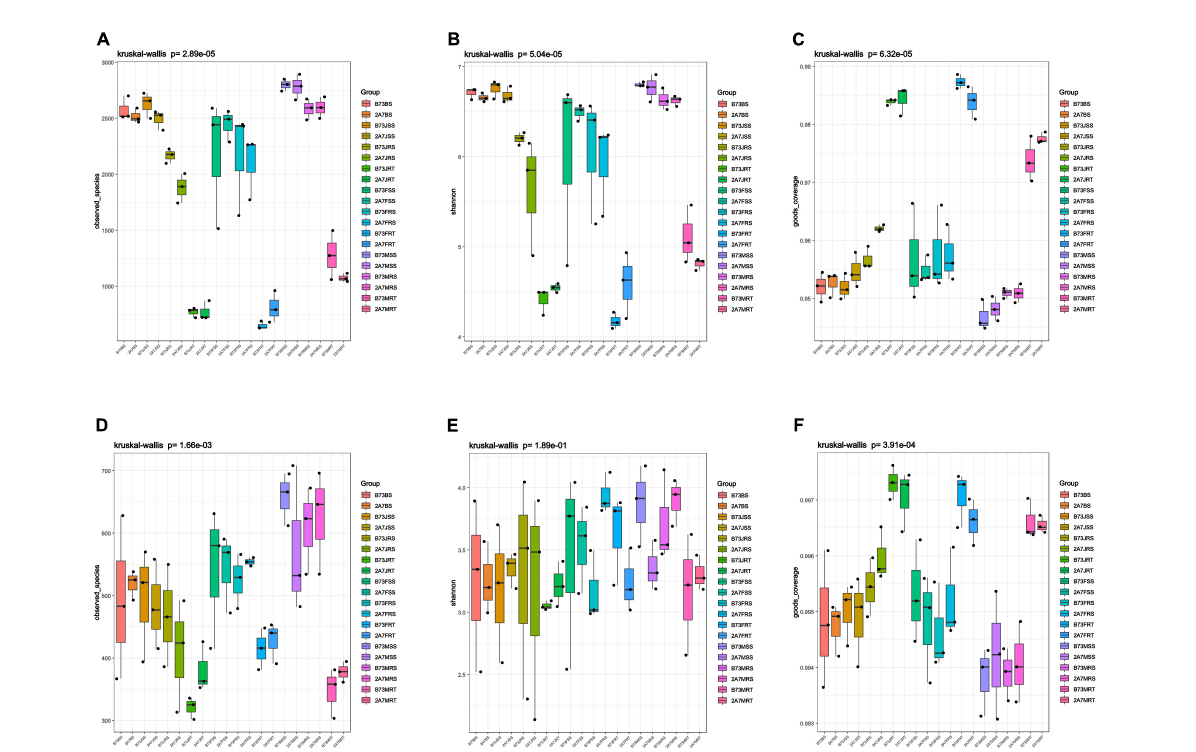
FIGURE2 The boxplot of alpha diversity of bacterial community (A–C) and fungal community (D–F) . The results of alpha diversity through three different indices (Observed species value, Shannon value, and Good’s coverage) were divided in two groups according to different sequencing results. B73 and 2A7 represent the control maize line B73 and the transgenic insect tolerant maize line 2A-7, respectively. J, F, and M represent the jointing, flowering, and maturing stages of maize, respectively. BS, SS, RS, and RT represent the bulk soil before planting, surrounding soil, rhizospheric soil and root samples, respectively. The mean and standard Error of Mean (SE) were calculated based on three alpha diversity indices of all replicates and the one-way ANOVA was used for multigroup comparisons.